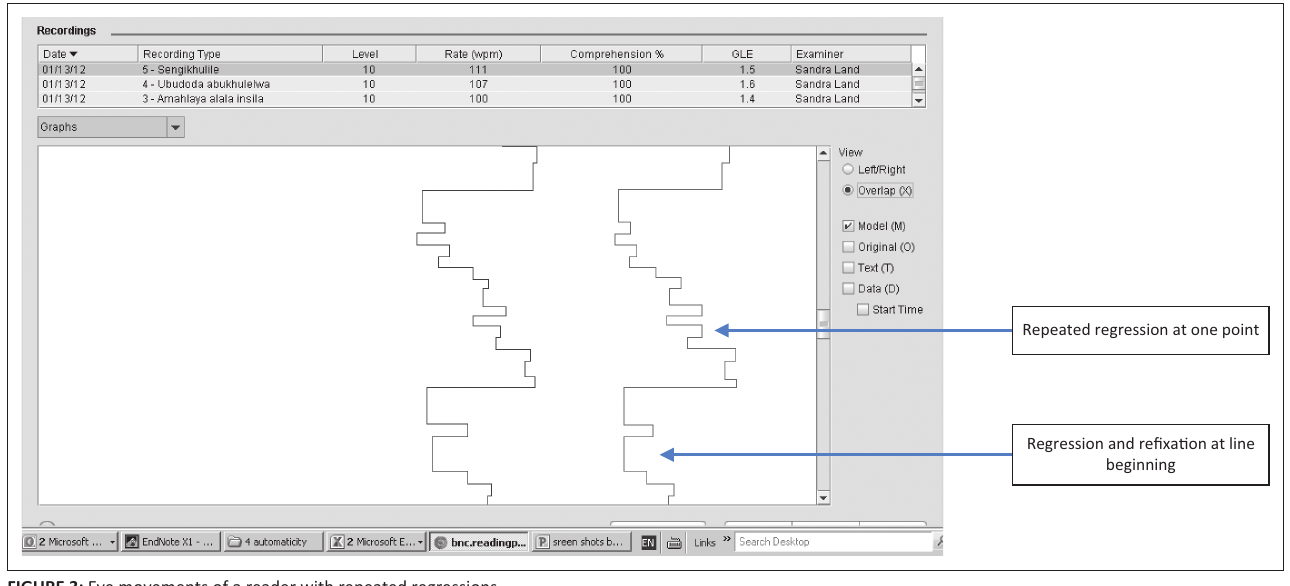
Regression and refixa(cid:18)on at line